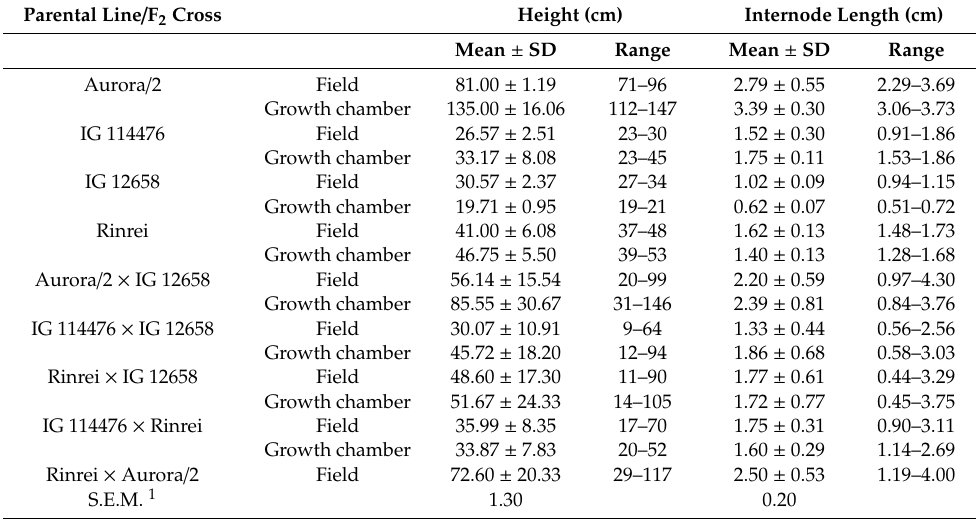
Table 1. The mean ± standard deviation (SD) and range for plant height and average internode length under the field and growth chamber conditions of parent lines and F 2 faba bean crosses.